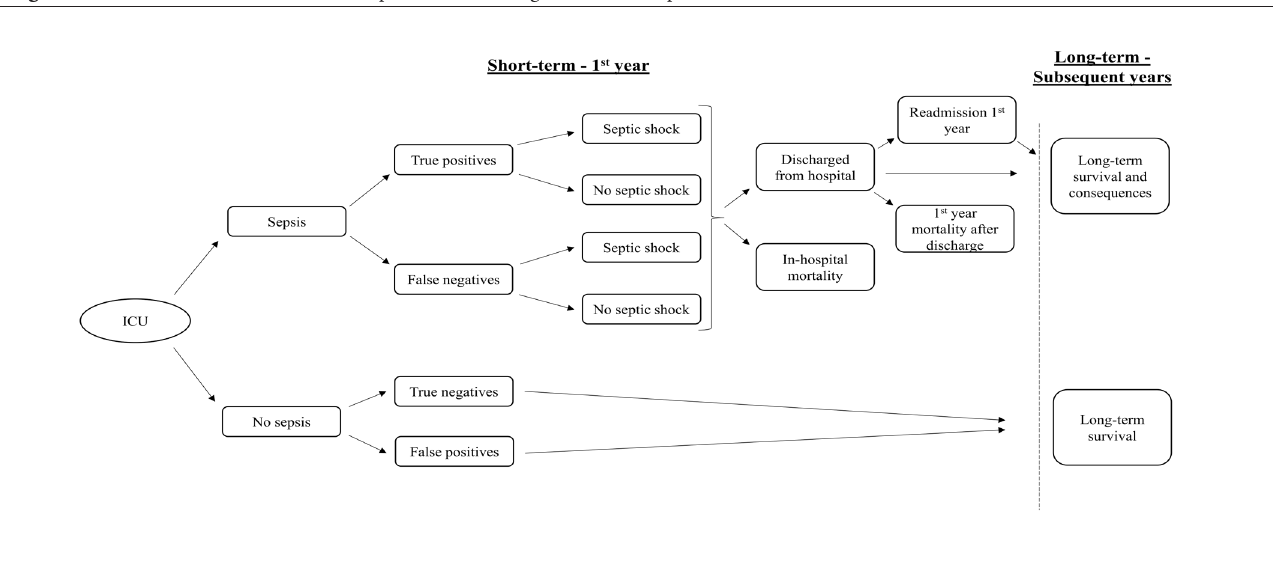
Figure 1. Model Structure for a Patient Population Not Diagnosed With Sepsis at Admission